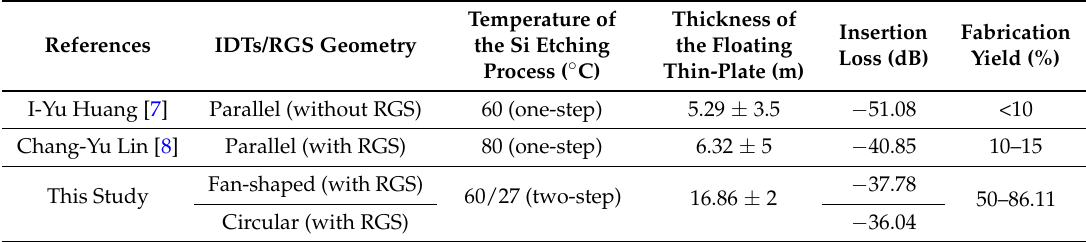
Table 2. Comparison of the IDTs/RGS geometry, silicon etching parameters, and FPW characteristics of the proposed focus-type and conventional FPW transducers [7,8].